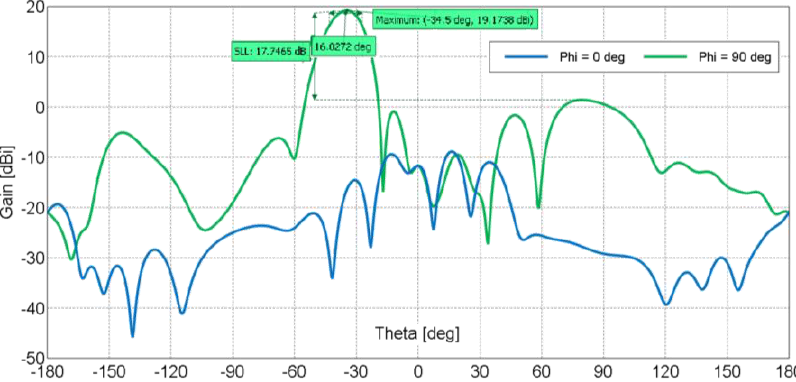
Fig. 9. The antenna array radiation pattern in Cartesian coordinates at beam angle of 35 degrees and frequency of 5